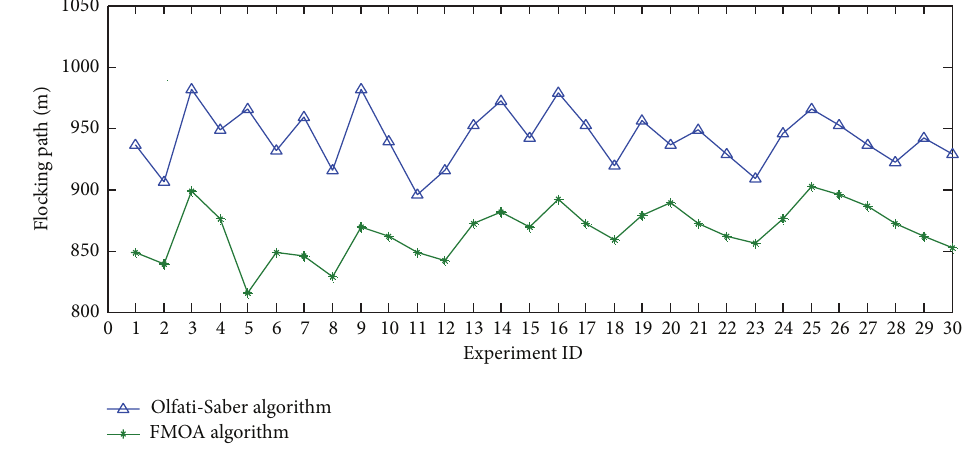
Figure 7: Experimental results about flocking path.